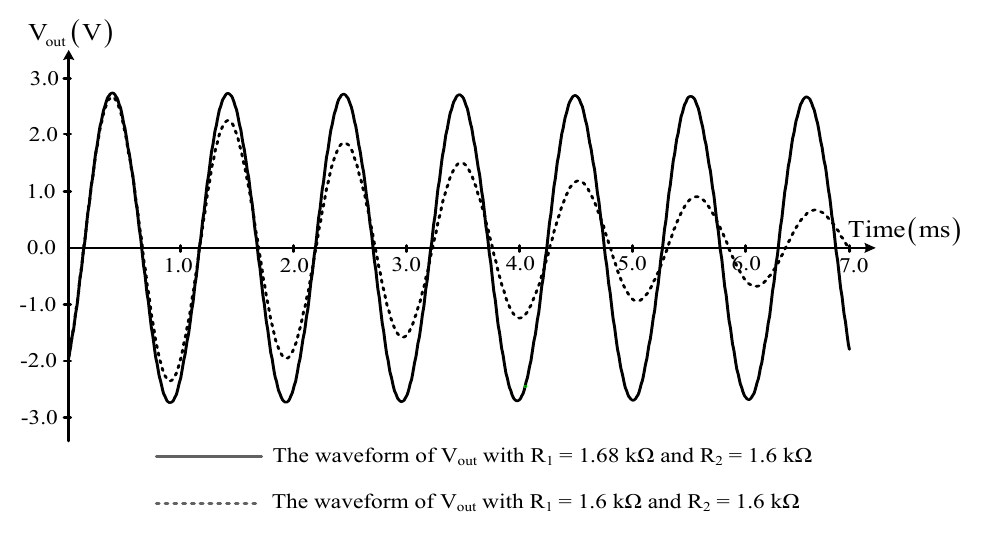
Figure 8. The output waveforms for the oscillator in Figure 4b with different oscillation conditions.